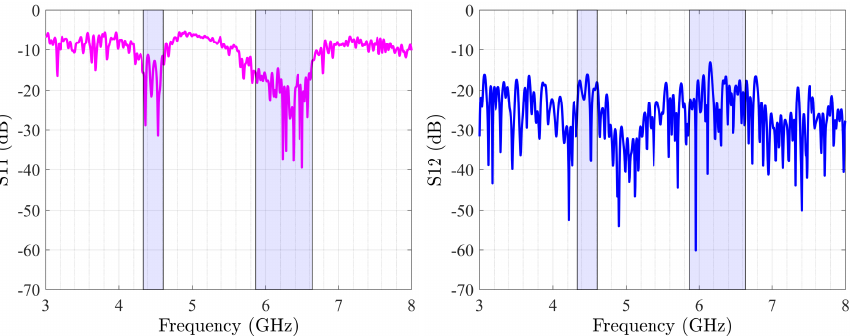
Figure 4. S 11 ( left ) and S 12 ( right ) of optimized implanted MIMO antenna array.